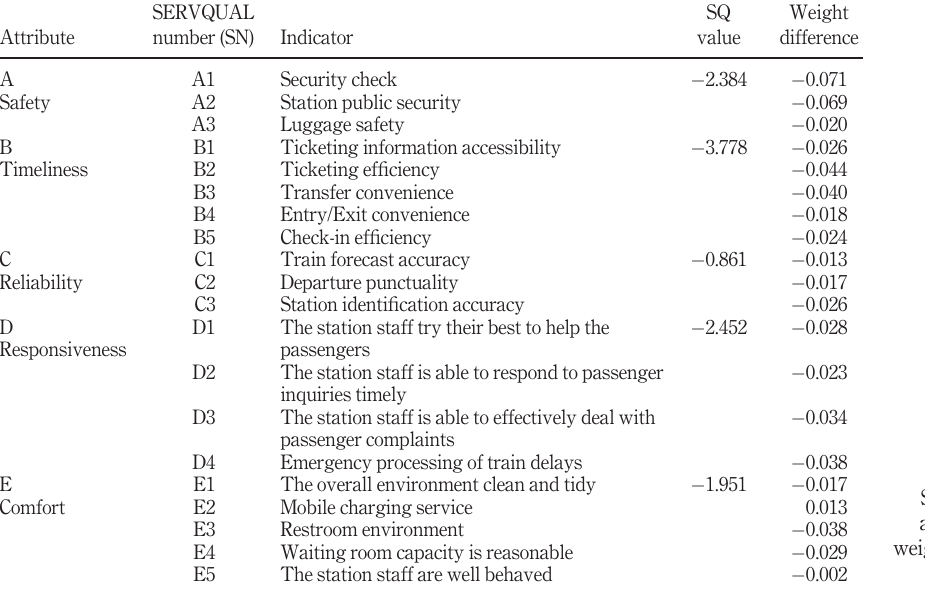
Table 3. Summary